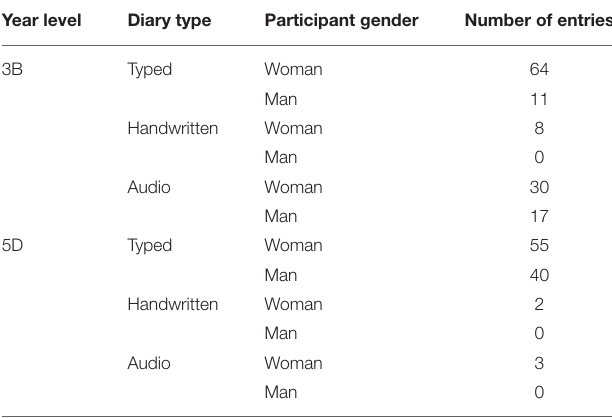
TABLE 1 | Number of diary entries submitted according to year level, diary type and participant